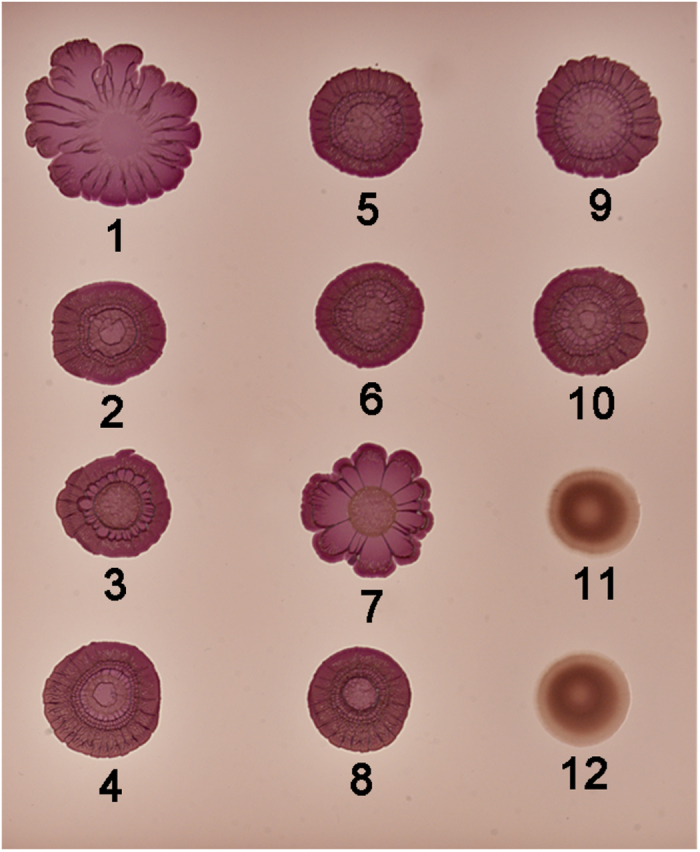
In vivo activity of σS variants and their sensitivity to Crl activation.Development of the red dry and rough (rdar) morphotype by S. Typhimurium strains harbouring wild-type and mutant rpoS alleles and the effect of a Δcrl mutation: spot 1, wild-type strain ATCC14028; spot 2, ATCC14028 Δcrl; spot 3, ATCC14028 rpoSPA; spot 4, ATCC14028 rpoSPA Δcrl; spot 5, ATCC14028 rpoSSTM-R82L; spot 6, ATCC14028 rpoSSTM-R82L Δcrl; spot 7, ATCC14028 rpoSPA-L87R; spot 8, ATCC14028 rpoSPA-L87R Δcrl; spot 9, ATCC14028 rpoSSTM-R82E; spot 10, ATCC14028 rpoSSTM-R82E Δcrl; spot 11, ATCC14028 ΔrpoS; spot 12, ATCC14028 ΔrpoS Δcrl.